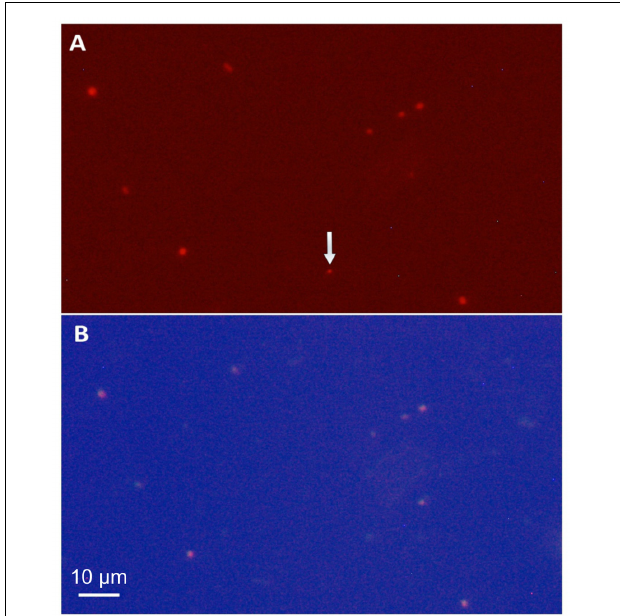
FIGURE 4 | Photomicrographs (1250 × ) of a 12 m depth sample from Tous reservoir. (A) Phycoerythrin fluorescence under a green filter showing all picocyanobacteria in the sample. (B) FISH microphotograph of the same microscopic field stained with the Cy3, Cy5 fluorescence labeled rRNA-targeted probe specific for Synechococcus sp. Tous (“SynTo”). Note that all picocyanobacteria except that marked by the arrow are targeted by the specific “SynTous” probe. Scale bars represent 10 µ m.